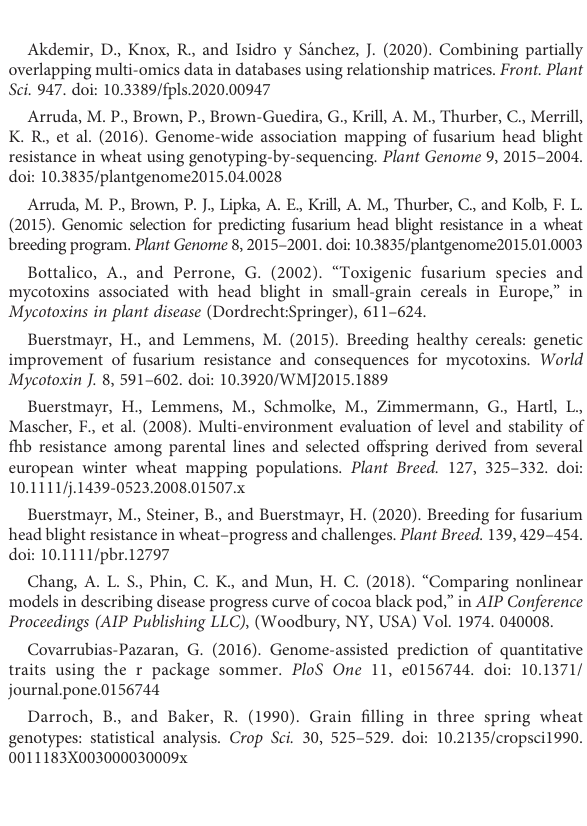
SUPPLEMENTARY FIGURE 1 Correlation between scoring metrics in fi eld trials. Diagonal grids show the normalized distribution of each score split by trial. Lower triangle grids show the pairwise scatter plots between the four scoring metrics. Upper triangle grids indicate the pairwise overall correlation (in gray) and the trial correlations between the four scoring metrics. Trials from Tulln, Feldkirchen and Vollebekk are denoted, respectively, by colors red, green and blue. Year 2020 is denoted with darker colors. SUPPLEMENTARY FIGURE 2 Correlation between the coef fi cient of variation (CV) of phenotypic distributions and the predictive accuracy (r) when all simulated information is available. Color and shape determine, respectively, the scoring metric and the heritability. Each dot represent one replicate (out of 30). SUPPLEMENTARY FIGURE 3 Disease stages coverage in each simulated assessment protocol. Each grid represents the disease development curves of simulated plots given the available information of the assessment denoted above. Dots represent simulated assessments and curves are constructed by connecting them. Red color indicate that there is no available information below 50% of disease in that plot and blue color indicate that there is no available information above 50% in that plot. Gray curves contains at leastone value below and above 50%. SUPPLEMENTARY TABLE 1 Absolute AUC values obtained from the heritability-accuracy interaction such those shown on . Row and column names denote, respectively, the assessment protocol and the scoring metric. Subtitles denote the value which is being predicted. Underlined AUC scores are the higher in each assessment protocol and predicted